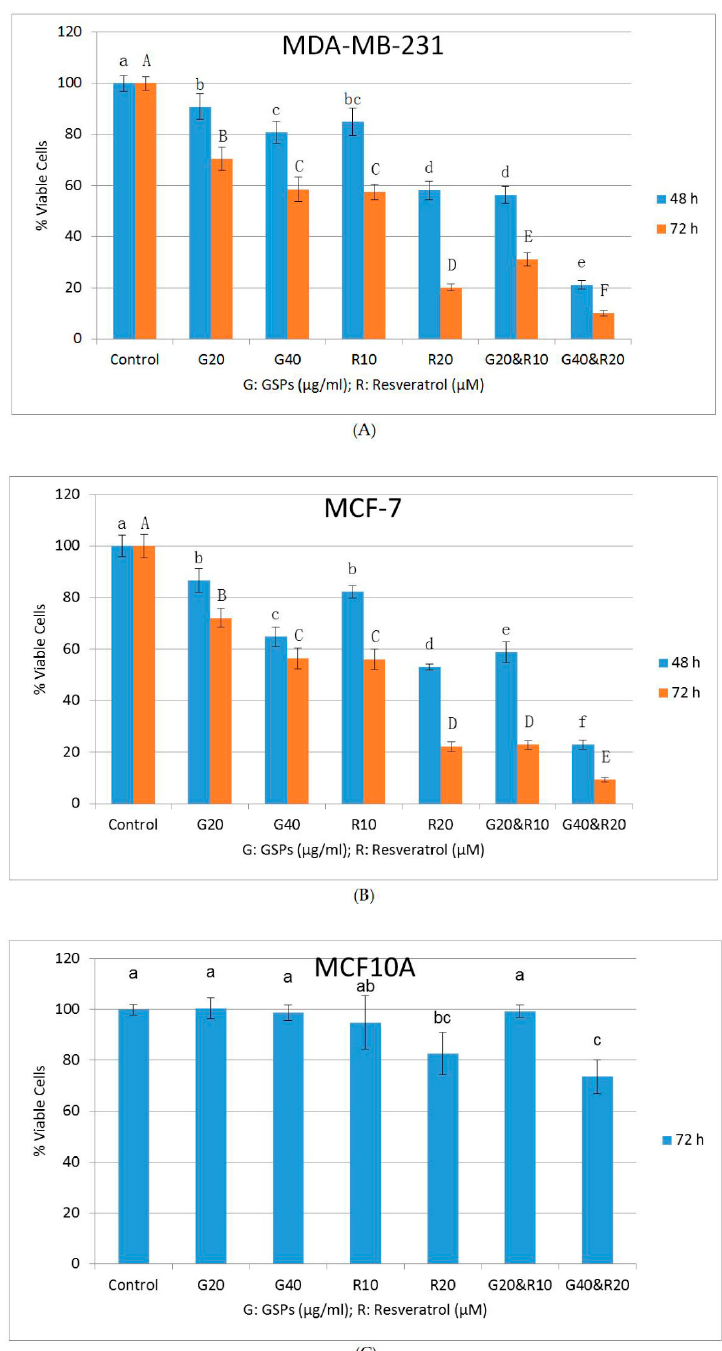
Figure 1. MTT Assay. I nhibition of cell viability in MDA-MB-231 ( A ) and MCF-7 ( B ) human breast cancer cells after treatment with grape seed proanthocyanidins (GSPs) (20, 40 μ g/ML), Res (10, 20 μ M), and their combinations (20 μ g/ML GSPs with 10 μ M Res, 40 μ g/ML GSPs with 20 μ M Res) as compared with the dimethyl sulfoxide (DMSO)-treated control cells for 48 h and 72 h. MCF10A human mammary epithelial cells ( C ) were used as the control cells to determine the toxicity of these phytochemicals of varying concentrations. Results were generalized from three independent experiments with very similar observations. The cell viability of each treatment group is represented in percentage compared with the control group as the mean ± SD. Mean values without any same superscript letter (lowercase letters for 48 h in MDA-MB-231 and MCF-7 cells and 72 h in MCF10A cells; uppercase letters for 72 h in MDA-MB-231 and MCF-7 cells) were considered to be significantly different ( p < 0.05).